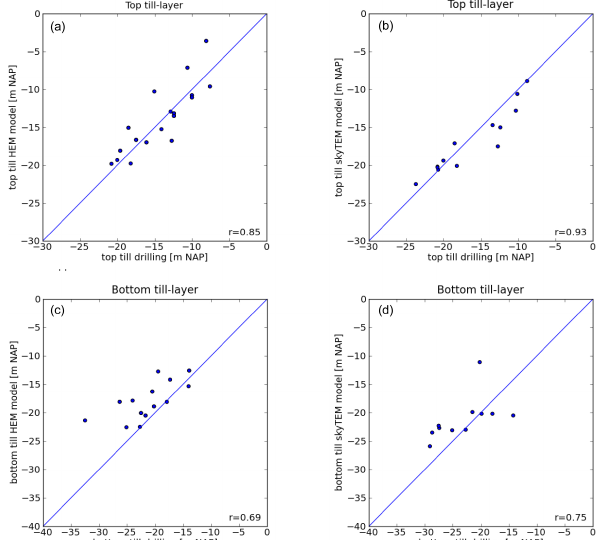
Fig. 16. Comparing top and bottom of till, as determined from ANN with top and bottom of the till in closest drilling (max. distance 75m); (a) top of the till from HEM, (b) top till from SkyTEM, (c) bottom of the till from HEM and (d) bottom of the till from SkyTEM. Correlation coefficient is given in the right-lower corner of each figure.